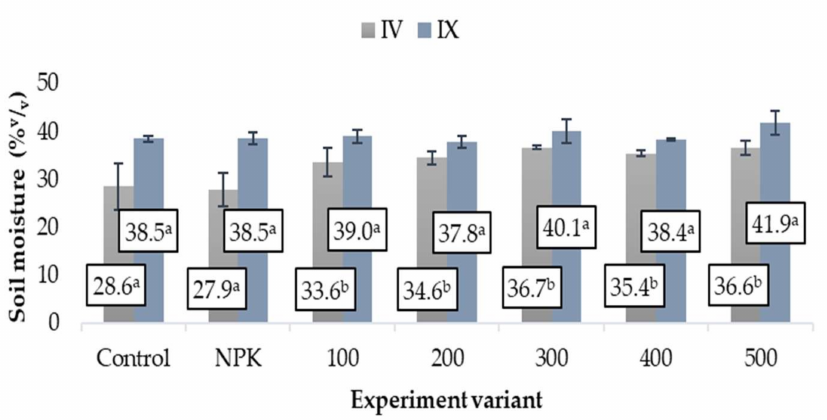
Figure 6. Changes in the moisture of the chernozem soil in IV (April) and IX (September) 2021 in the 0–5 cm layer after the application of biomass combustion ashes (mean ± SD). Treatments not sharing the same letter(s) are statistically significant at p < 0.05 (Tukey’s